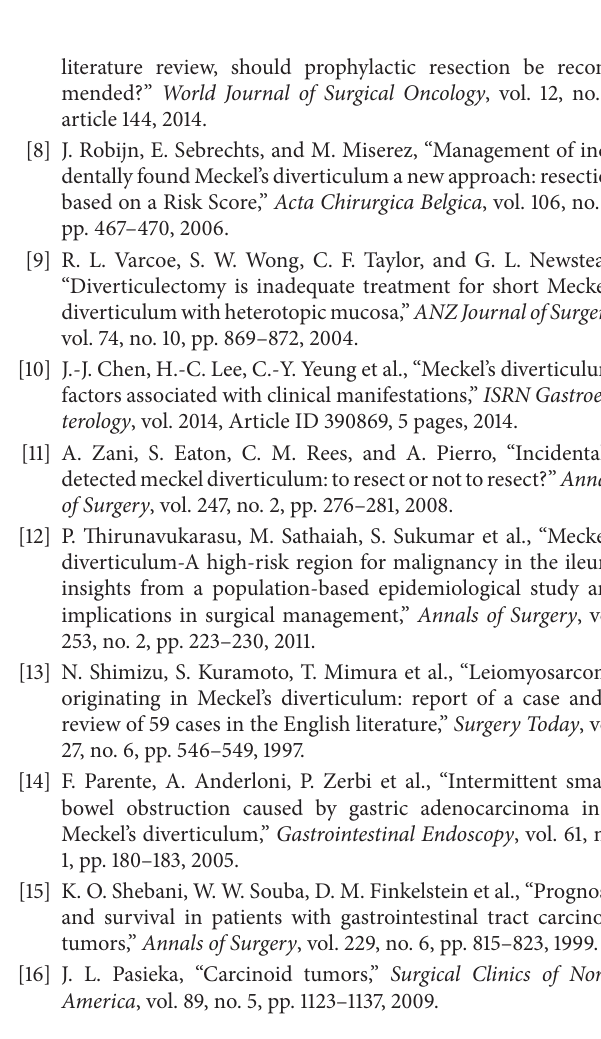
Figure 6: Histological analysis of this carcinoid found it to have a low proliferation index and therefore consistent with that of a low grade neuroendocrine tumor. Additional confirmatory immunohistological analysis found its cells to be positive for (a) synaptophysin and (b)